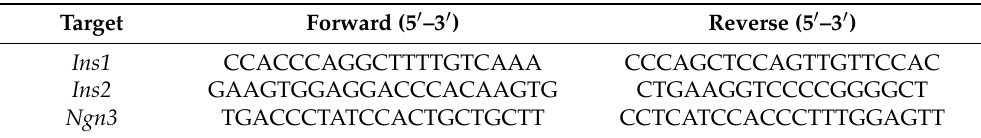
Table 2. Primers used in mRNA expression